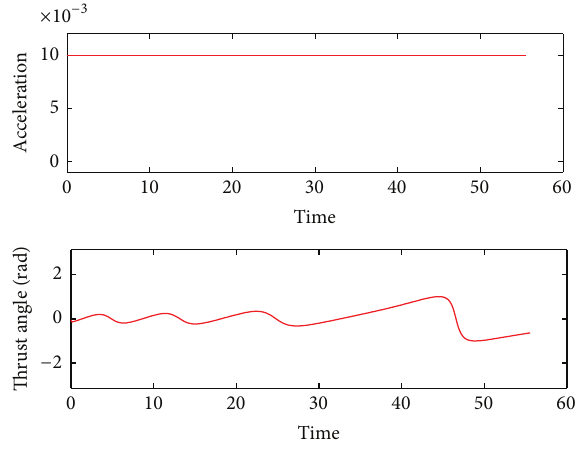
Figure 11: Two-body orbit transfer in polar coordinates.